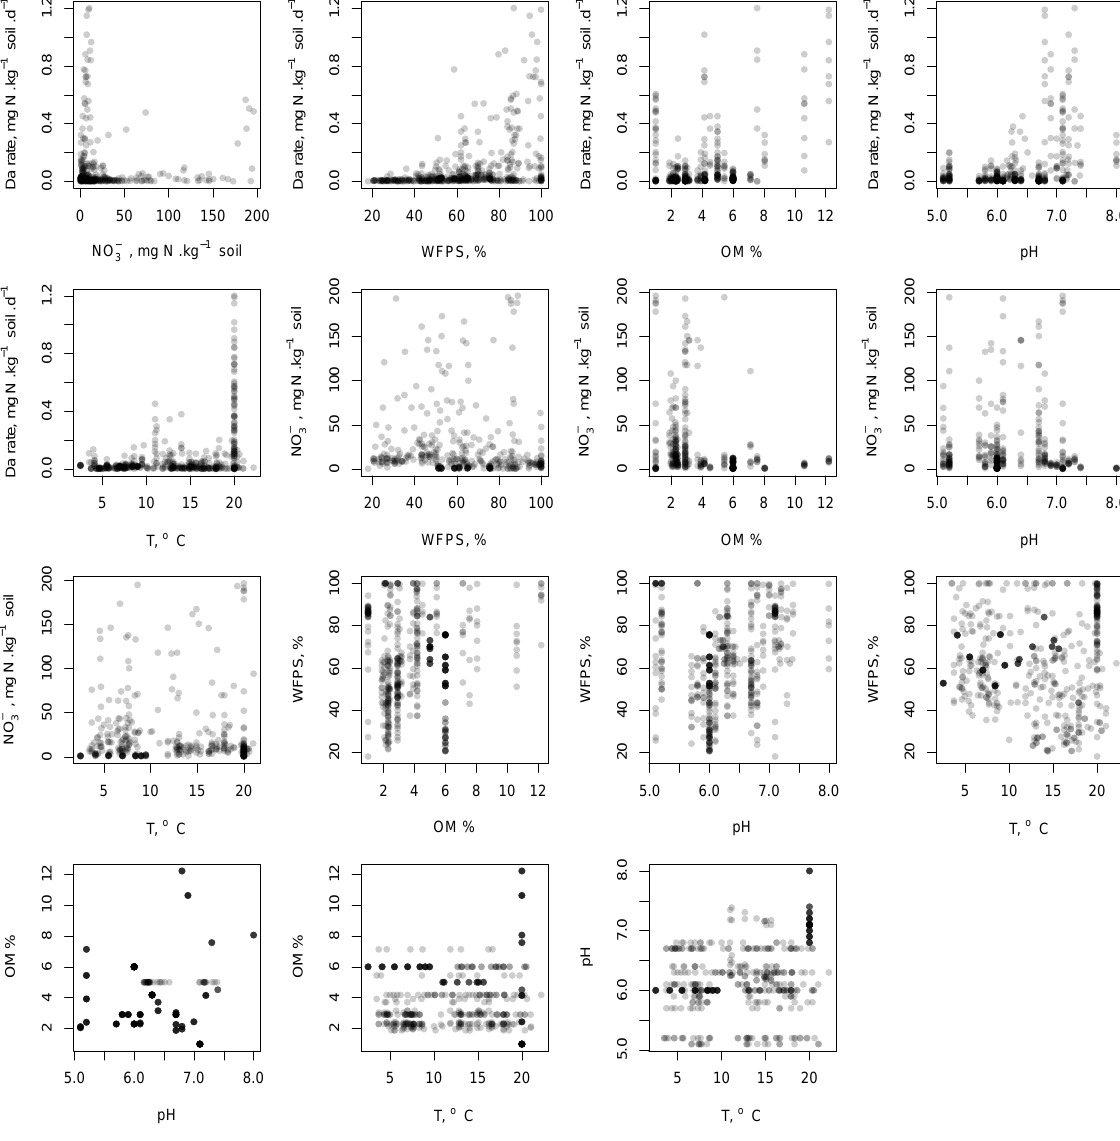
Fig. D1. Scatterplots of the combination of Da , NO − , WFPS, OM, pH and T . A light grey dot represents one data point. Dots get darker as 3 data points overlap. NO − range is limited to 200mgNkg − 1 soil as there is few data between 200 and 800mgNkg − 1 3